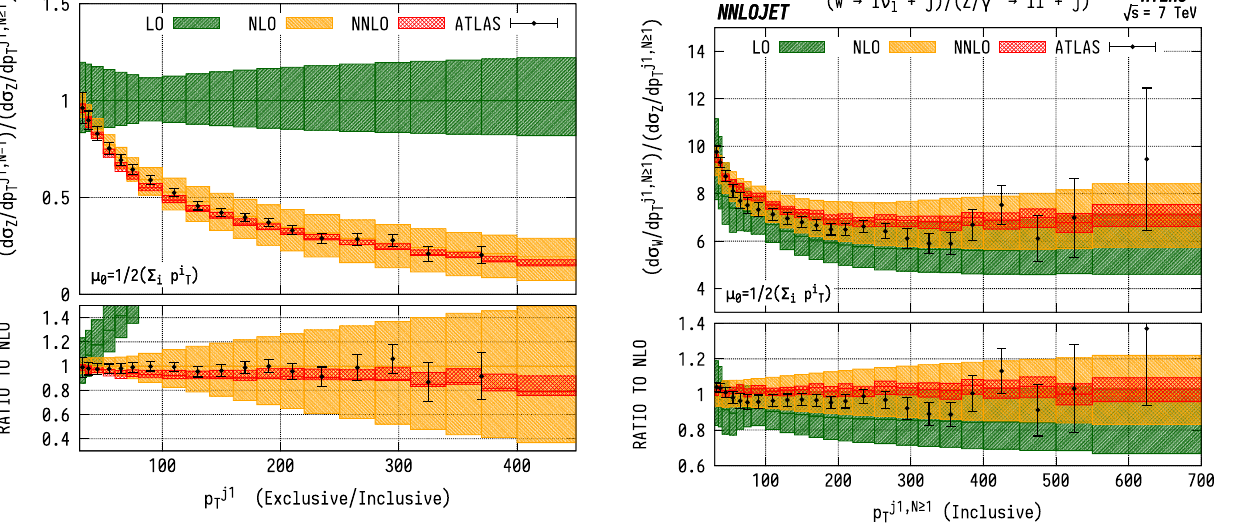
Fig. 21 WJ / ZJ ratio differential in the inclusive p T of the leading jet ( N ≥ 1 ) . See Fig. 20 for